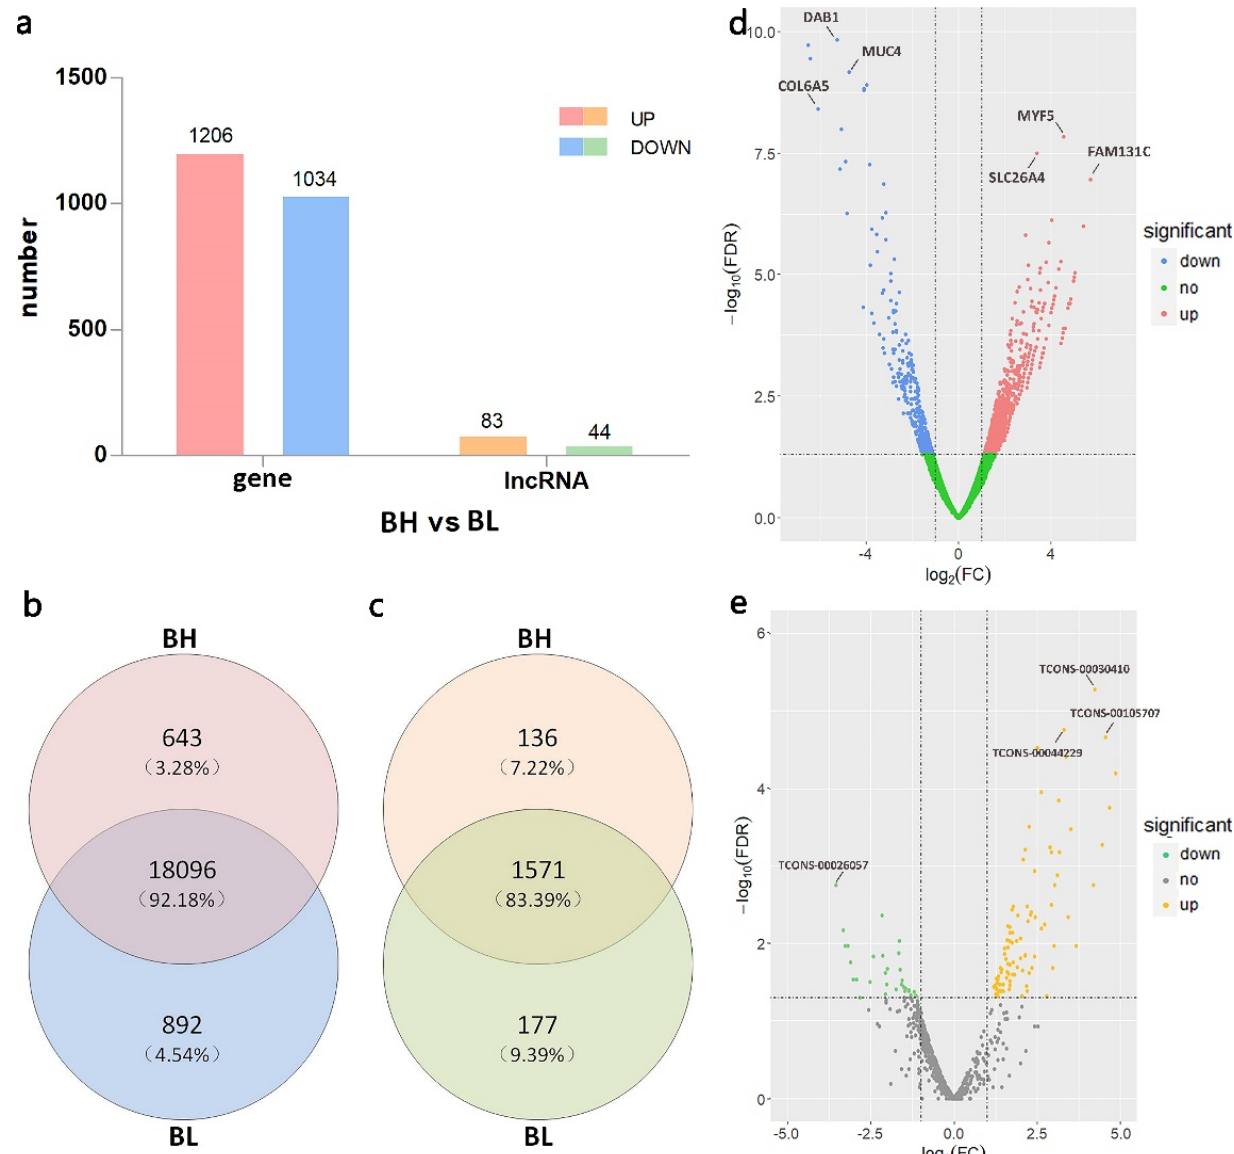
Figure 3. Expression of genes and long non-coding RNAs (lncRNAs) in extremely high- and low-backfat pigs based on the pooling RNA sequencing (RNA-seq). ( a ) Number of differentially expressed lncRNAs (DELs) and differentially expressed genes (DEGs) between the BH and BL groups; ( b ) Venn diagram of the genes from each group; ( c ) Venn diagram of the lncRNAs from each group; ( d ) Volcano plot of DEGs. The Y-axis is the value of − log10 (false discover rate [FDR]) and the X-axis is the value of log2(FC). The two threshold lines show the standard of FDR = 0.05 and FC = 2; ( e ) Volcano plot of DELs. We have annotated the most significant DEGs and DELs in the volcano.